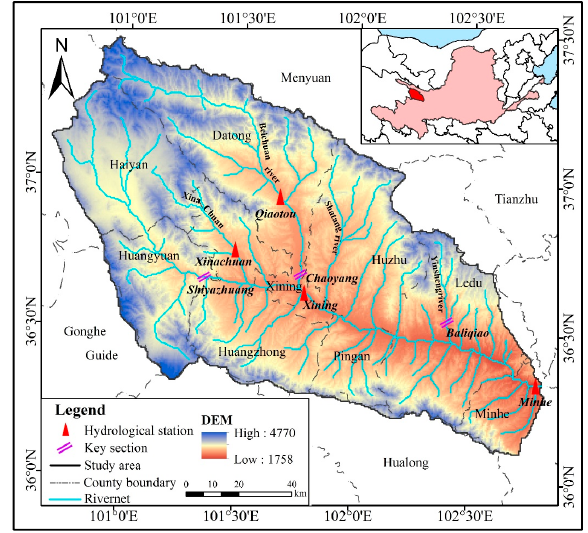
Figure 1. Location, elevations, hydrological stations, and key sections of the Huangshui River basin.